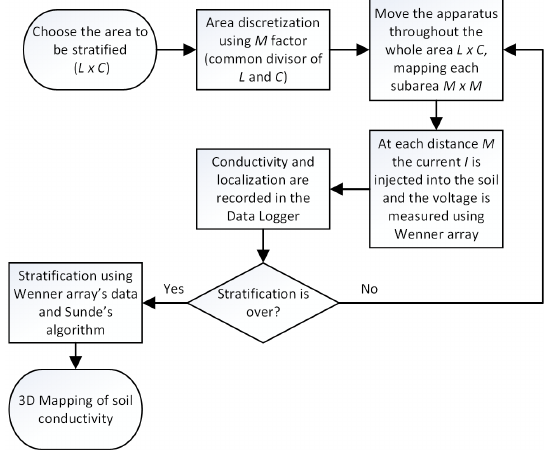
Figure 12. Flowchart for use of proposed methodology and device.